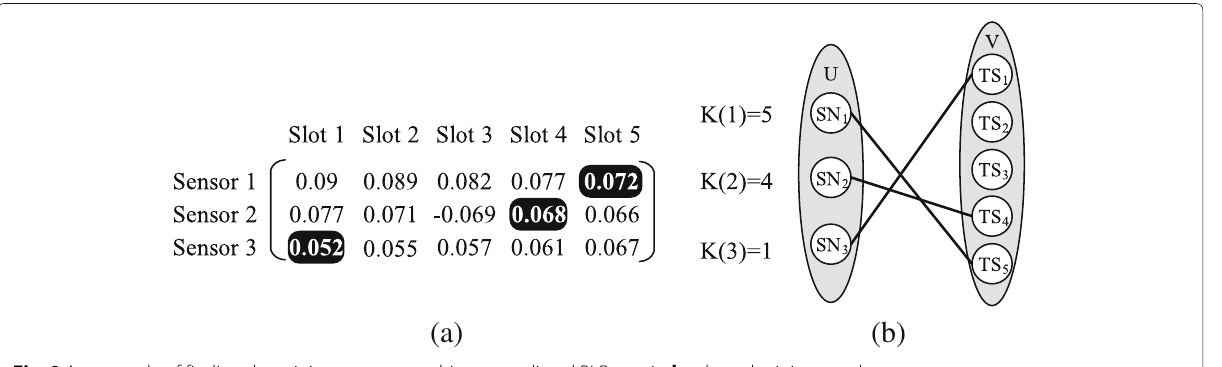
Fig. 9 An example of finding the minimum cost matching. a predicted PLR matrix. b selected minimum edges